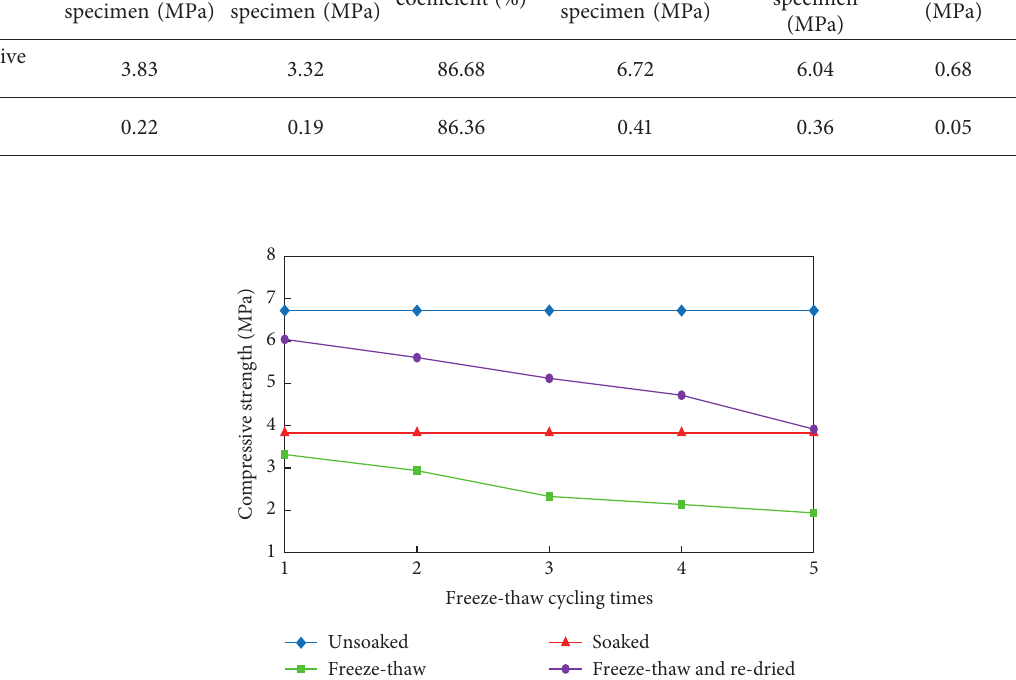
Figure 20: The unconfined compressive strength of specimens under different freeze-thaw